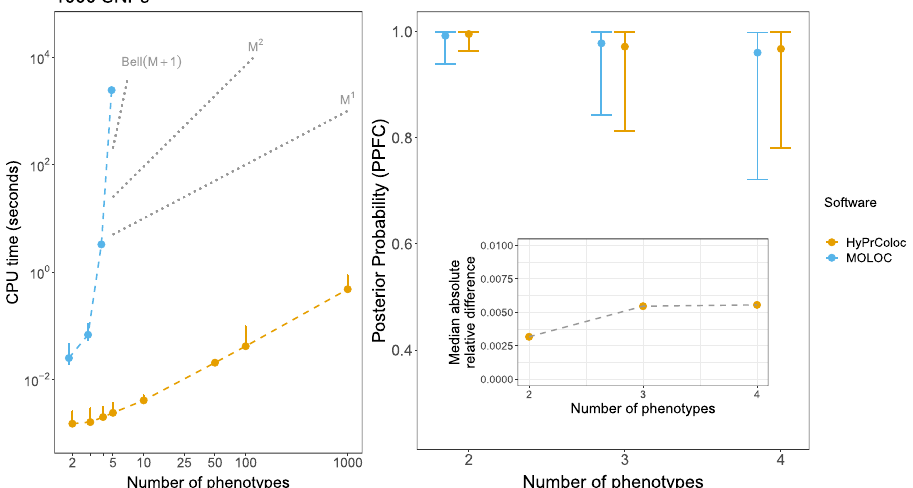
Fig. 3 Comparison of HyPrColoc and MOLOC computation time and posterior probability of colocalization. (Left panel) Computation time (seconds) for HyPrColoc (yellow) and MOLOC (blue) to assess full colocalization across M ≤ 1000 traits in a region containing Q = 1000 SNPs. MOLOC was restricted to M ≤ 5 traits owing to the computational and memory burden of the MOLOC algorithm when M > 5. When M = 5, we summarise the computation time of MOLOC from 10 datasets - as it took around 1 hour to analyse a single dataset, in all other scenarios performance was summarised from 1000 datasets. Three reference lines are plotted: (i) Bell ( M + 1), which denotes the theoretical cost of exhaustively enumerating all hypotheses; (ii) M 2 , denoting quadratic cost and; (ii) M 1 , denoting the linear complexity of the HyPrColoc algorithm. (Right panel) Distribution of the posterior probability of colocalization between all traits, i.e. the posterior probability of full colocalization (PPFC), using HyPrColoc (yellow) and MOLOC (blue) across M ∈ {2,3,4} traits. Error bars denote the 1st and 9th deciles and a point denotes the median value. Despite differences in the prior set-up between the methods, the median absolute relative difference between the two posterior probabilities was ≲